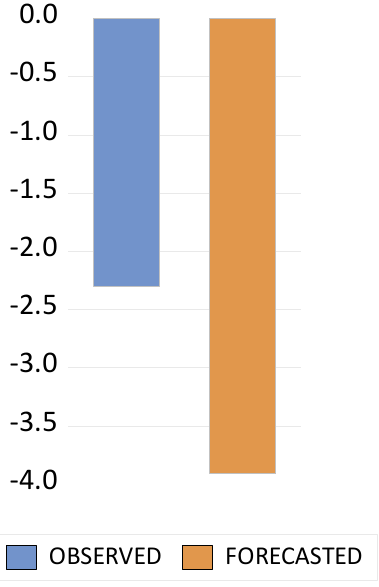
Figure 6 : Cumulative observed and forecasted GDP growth rates